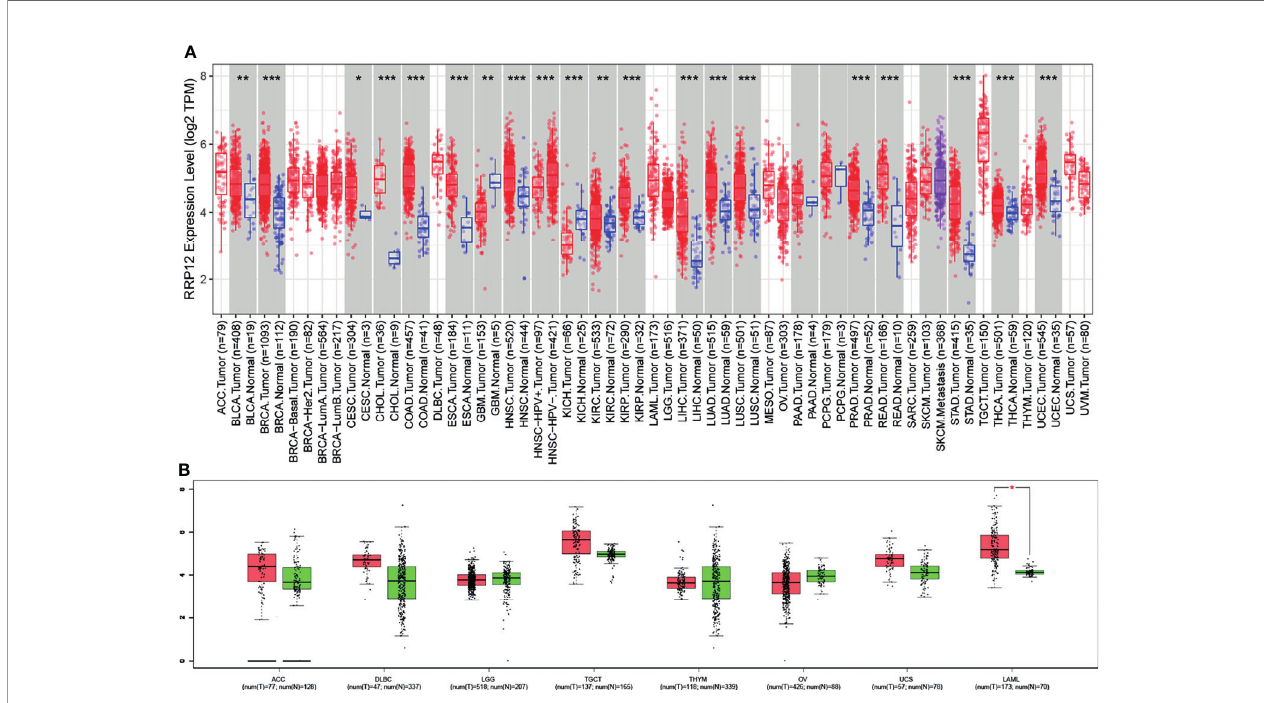
FIGURE 1 | The transcriptional level of RRP12 in different types of cancer. (A) The transcriptional level of RRP12 in different types of cancer in the TIMER database. (B) Supplement to TIMER database based on GEPIA database. *p value < 0.05; **p value < 0.01; ***p value <